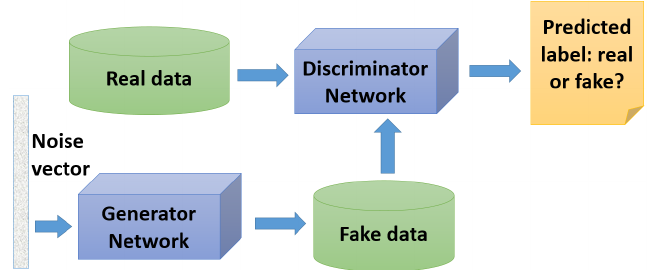
Figure 2. Standard architecture of the